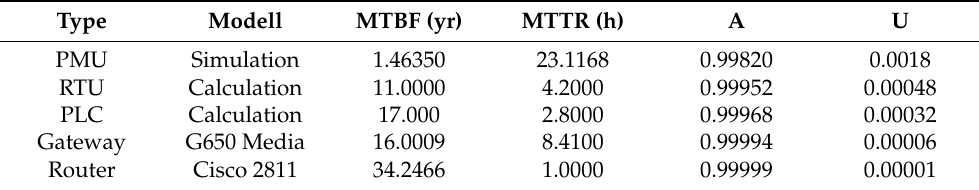
Table 8. Reliability of selected communication components; elaborated on the basis of